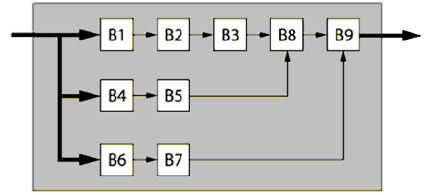
Figure 1. Accelerating data processing via parallelism.